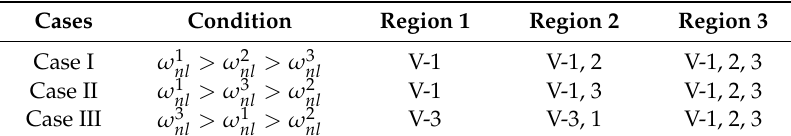
Table 2. The Regional Conditions of Different Cases.